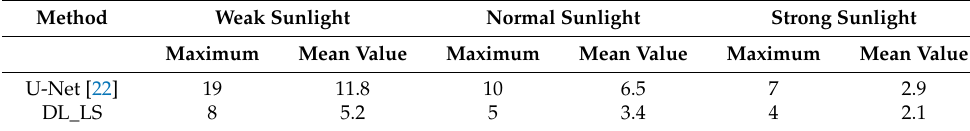
Table 5. Comparison of centerline maximal pixel errors of different methods.